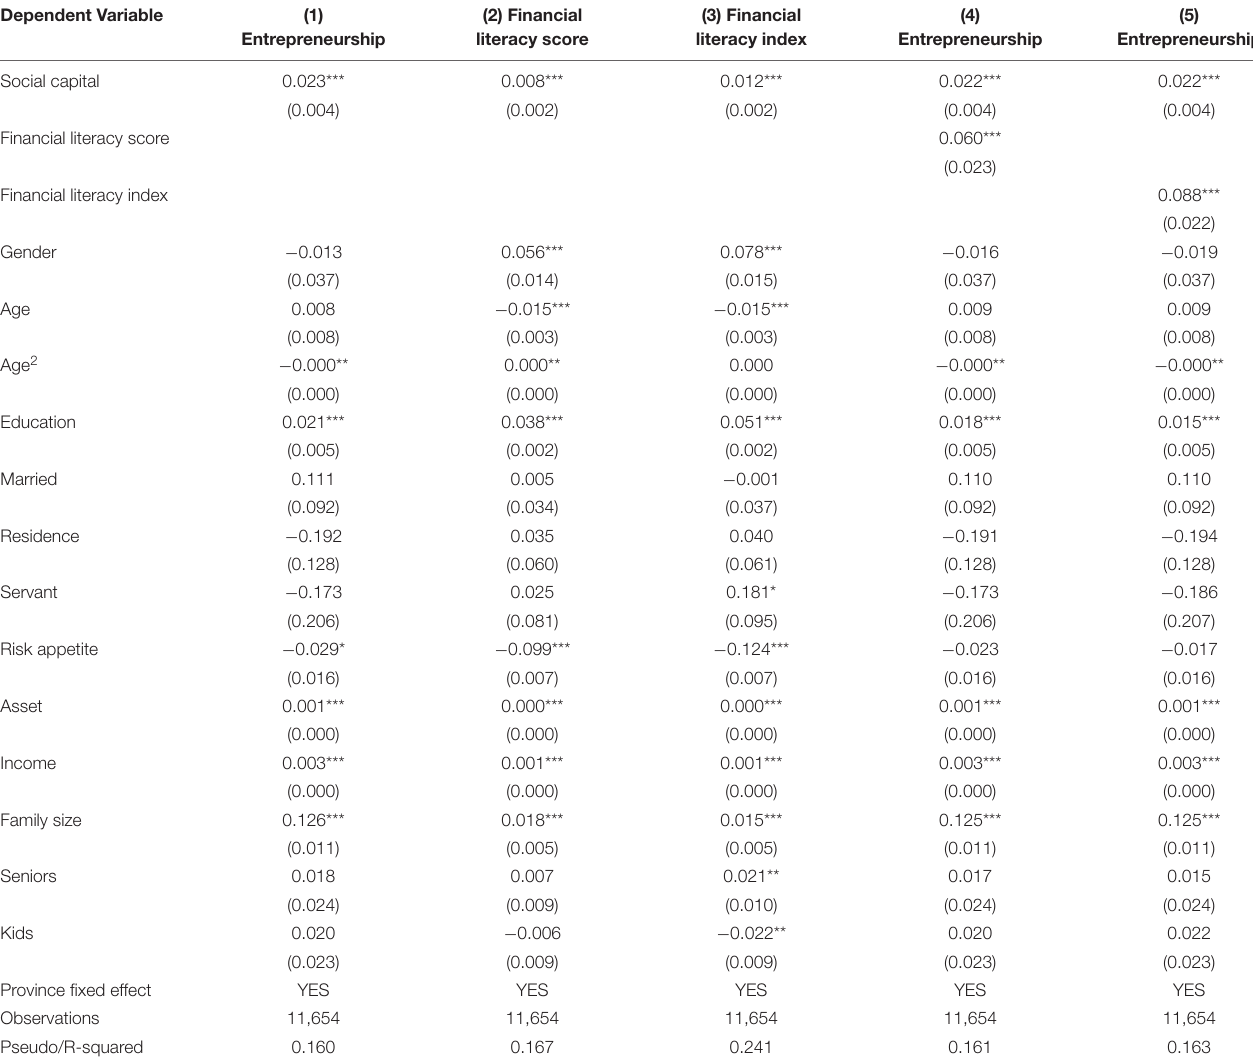
TABLE 7 | Estimation of the effect of social capital on entrepreneurship and financial literacy. Dependent